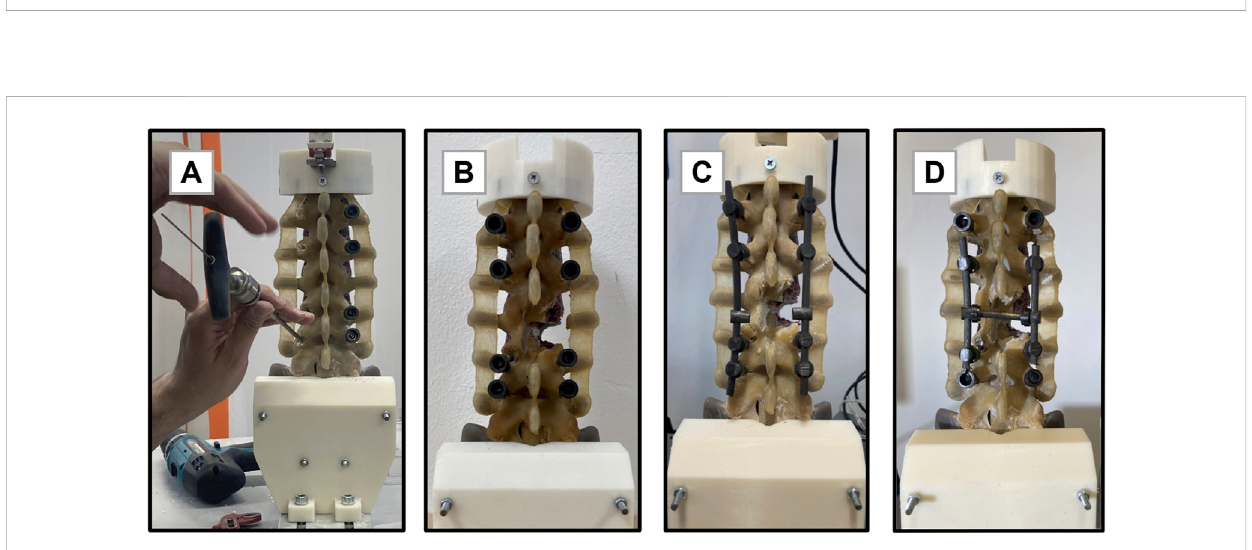
FIGURE 2 Key steps of the experimental design. (A) : Insertion of thepediclescrews in the lumbar biomimeticphantom using the Carboclear system (CarboFix OrthopaedicsLtd.). (B) :Osteolyticlesionandposteriordecompressionreplicabeforetheapplicationofstabilizations. (C) :Realizationofthelongsegment stabilization. (D) : Realization of the short segment stabilization with the transverse